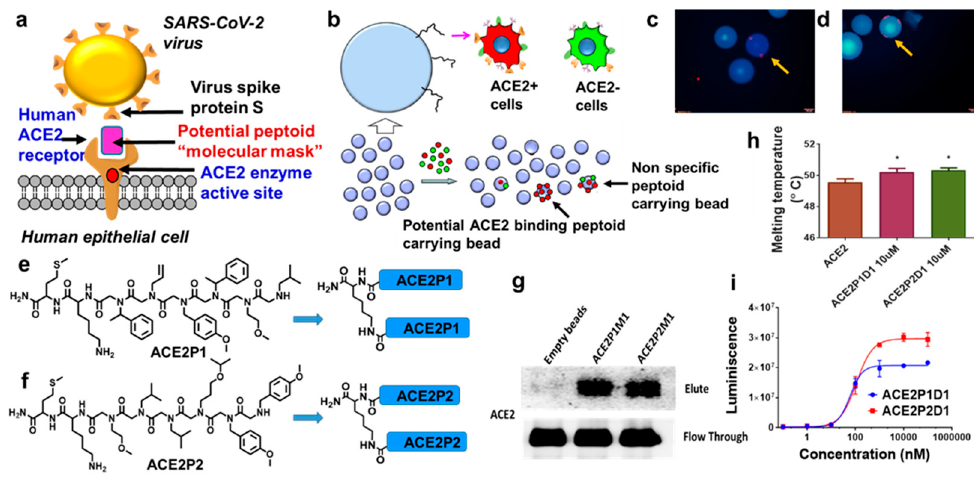
Figure 1. OBTC peptoid screen identifies two potential human ACE2 binding peptoids. ( a ) Schematic representation of SARS-CoV-2 virus spike protein S binding to human ACE2 receptor and the idea of developing ACE2 receptor binding peptoids as “molecular masks”. ( b ) Outline of the OBTC assay. Two identical cell groups that defer only by ACE2 receptor expression were exposed to 50,000 TentGel resin beads that display peptoids in one-bead one-compound library format. ACE2+ (positive) MCF-7 cell group was stained in red, and AC2- (knocked down) MCF-7 cell group was stained in green, mixed 1:1 and exposed to the peptoid library. A bead bound only with red stained cells indicates having the peptoid ligand that selectively bound to ACE2 receptor over all other molecules found on MCF-7 cell surface. Beads bound with both red and green cells were discarded as non-specific peptoid carrying beads. ( c , d ) Fluorescence microscopic images of beads bound with only red stained cells (only two such beads were found, as indicated by the arrows). ( e , f ) Chemical structures of peptoids found on those 2 beads, named as ACE2P1 and ACE2P2, respectively. The optimized simple dimerized structures ACE2P1D1 and ACE2P2D1 are shown after the arrows. ( g ) TentaGel beads carrying ACE2P1 and ACE2P2 peptoids or empty beads (as control) were incubated with recombinant ACE2 protein. The beads were washed thoroughly, and protein was eluted and analyzed by Western blot. Blots were cropped from different parts of the same gel. ( h ) Recombinant ACE2 protein (5 µg) was incubated with 10 µM ACE2P1D1 or ACE2P2D1 (dimer form of the peptoids). Thermal shift assay was performed using a QuantStudio 3 Real-Time PCR System. Each bar represents the mean + standard deviation ( n = 3/group), * p < 0.05. ( i ) ELISA-like quantitative ACE2-peptoid binding assay was performed with coating 96-well plates with recombinant human ACE2 treatment with increasing concentrations of peptoids and probing bound peptoids via luminescence. The data analysis indicates dissociation constant (Kd) values of 60 and 110 nM. The error bars represent the standard deviation between duplicates.